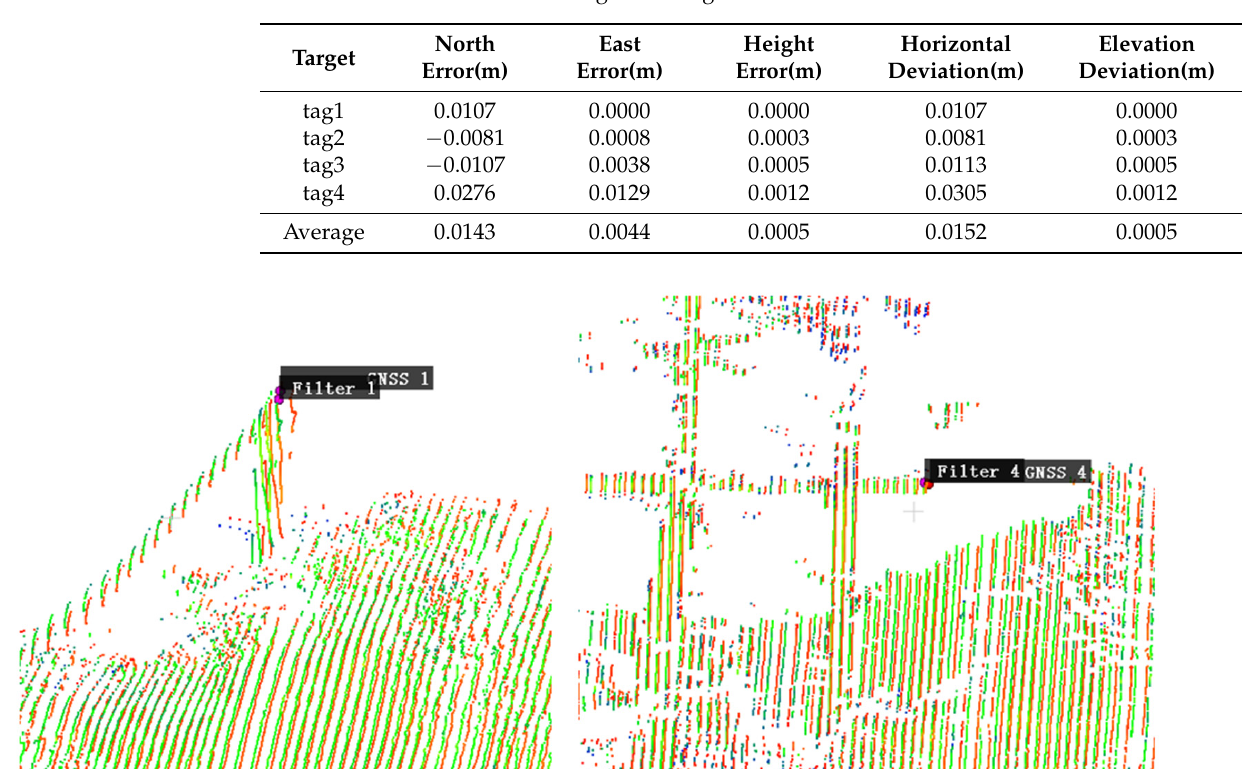
Figure 23. Multi-sensor fusion generated point cloud and integrated navigation generated point cloud with the same name point selection.